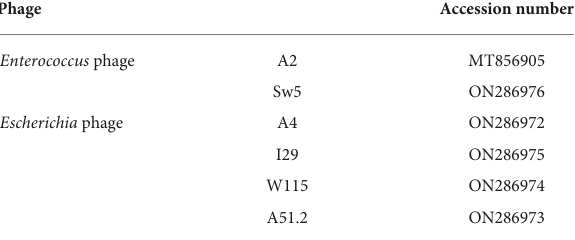
TABLE 1 GenBank submission numbers for phages of